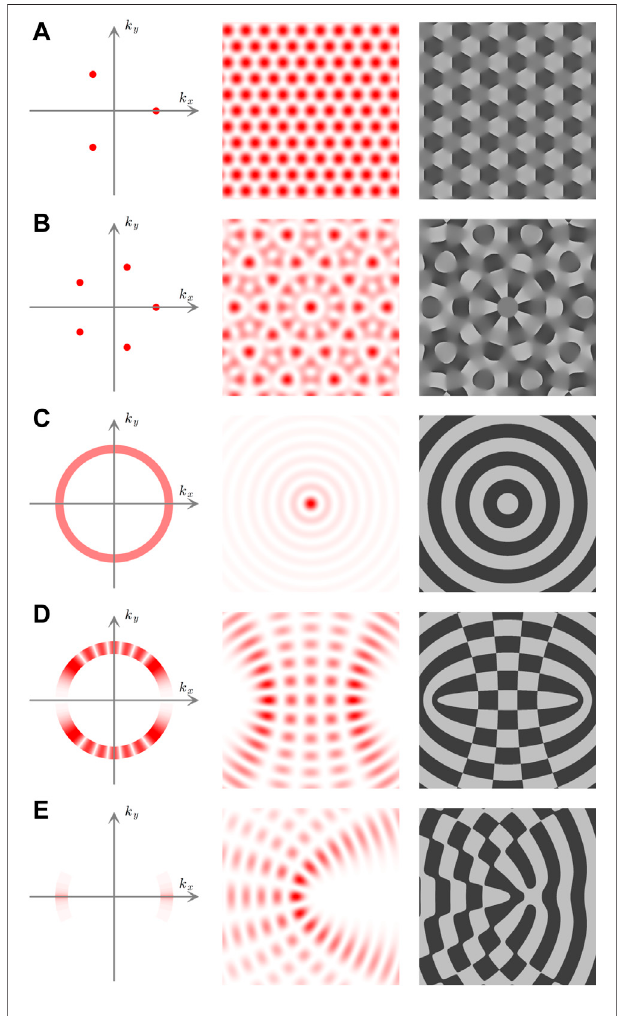
FIGURE 1 | Non-diffracting beams. (Left) Spatial spectrum, (middle) intensity, and (right) phase pro fi les for (A) periodic hexagonal, (B) quasiperiodic fi vefold tilings, (C) Bessel beam, (D) even Mathieu beam, (E) even Webber beam. Reproduced with permission from the original author